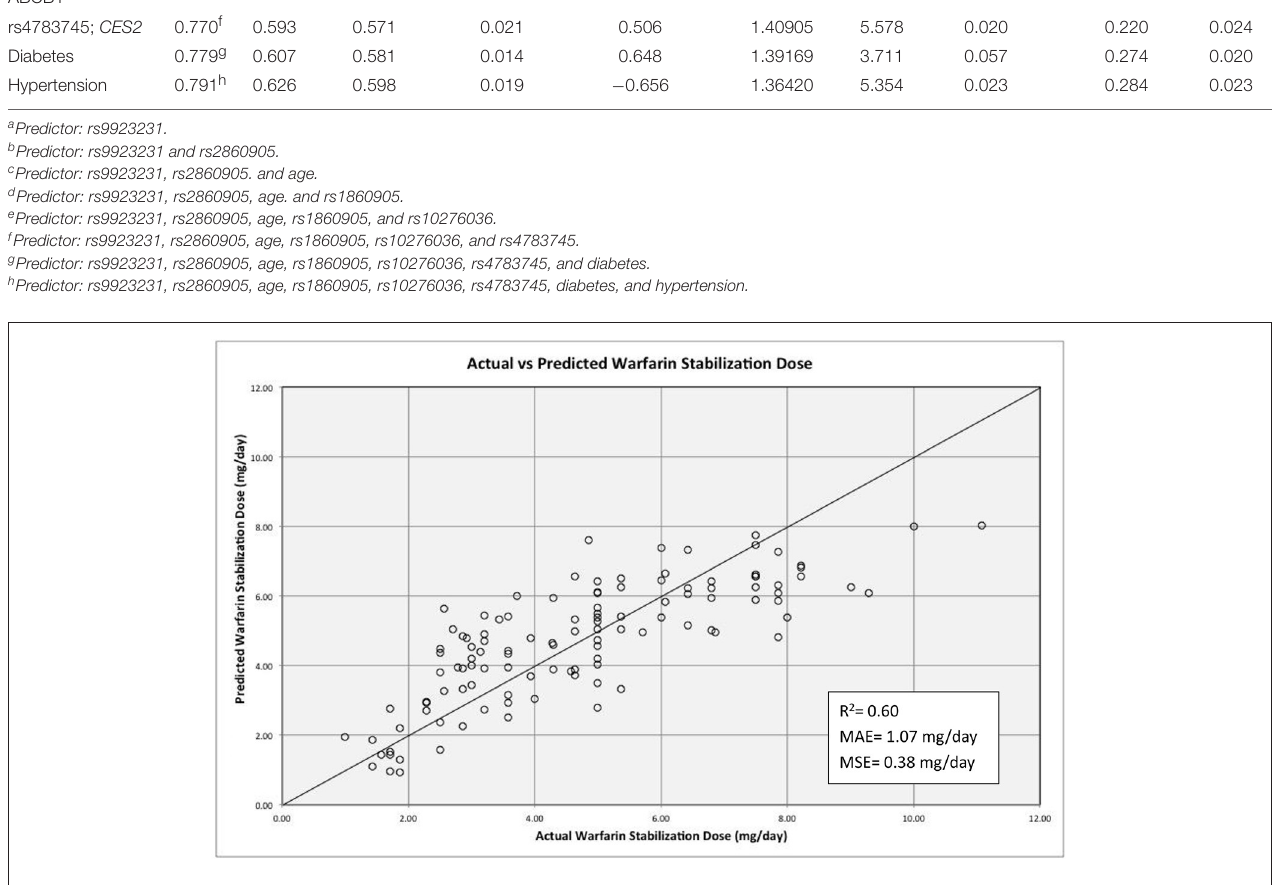
FIGURE 6 | Regression model for warfarin dose requirements among Puerto Ricans. The solid line depicts perfect prediction of the model. The stabilization dose refers to the dose given after three consecutive INRs values within the range (2–3 for most of the indications). The R 2 value is adjusted. MAE and MSE stand for mean absolute error and mean standard error